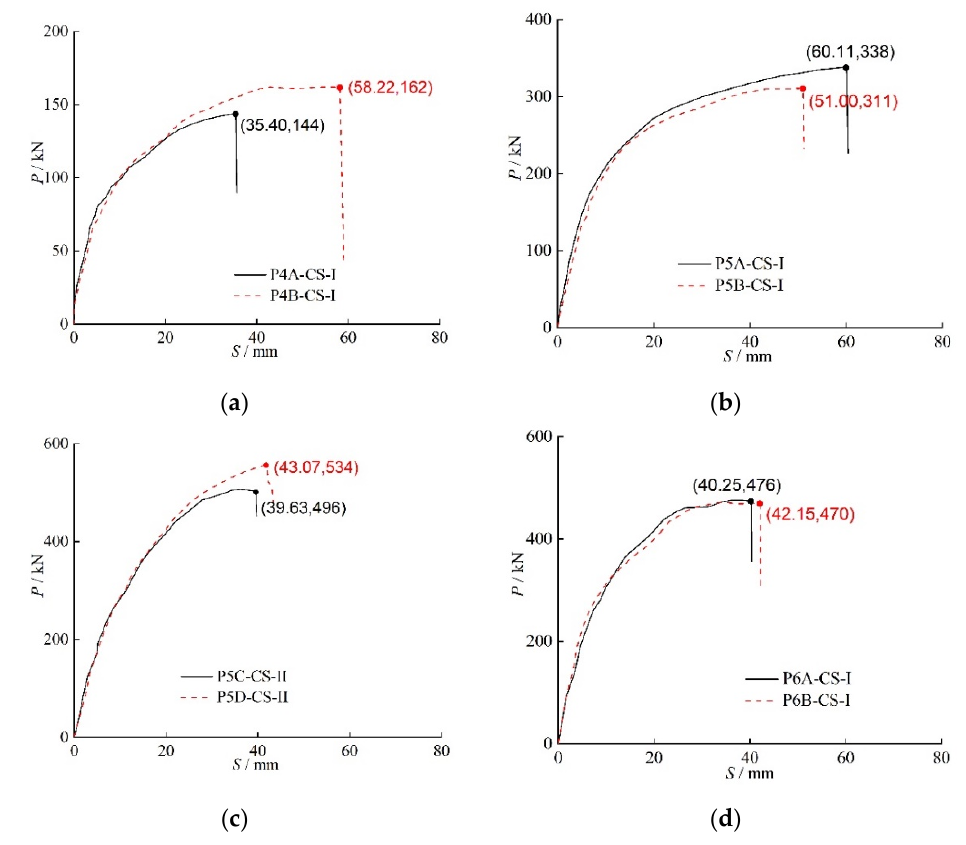
Figure 9. Relationship between the load and the midspan displacement: ( a ) P4A-CS-I/P4B-CS-I, ( b ) ( b ) P5A-CS-I/P5B-CS-I, ( c ) P5C-CS-II/P5D-CS-II, ( d ) P6A-CS-I/P6B-CS-I.